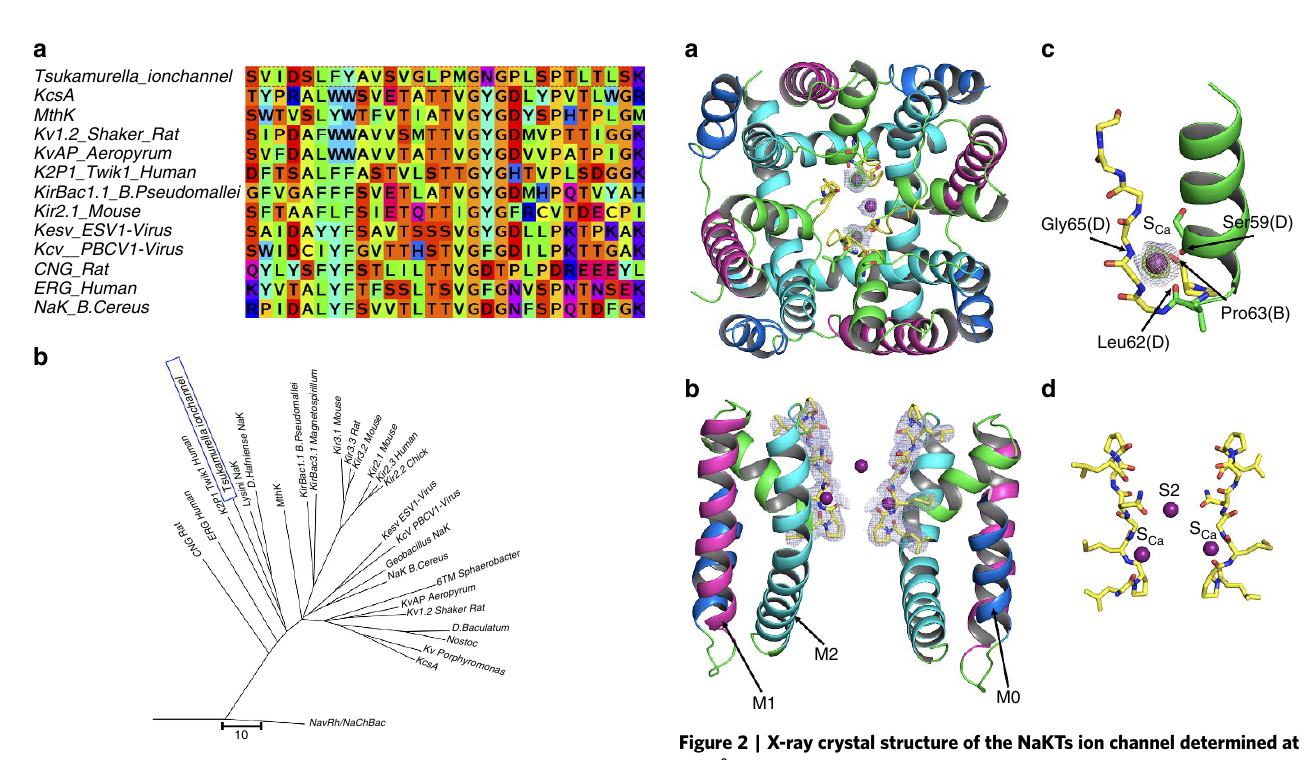
Figure 1 | The NaKTs ion channel in relation with other tetrameric cation channels. ( a ) Multiple sequence alignment of the pore helix and selectivity filter regions for the NaKTs ion channel protein along with K þ , Na þ and non-selective channels. The multiple sequence alignment was done using Clustalw and JalView (the colour coding is based on the Taylor scheme available in JalView). ( b ) Phylogenetic tree (scored from pore helix and filter region). The phylogenetic tree was generated based on the multiple sequence alignment of the pore helix and the selectivity filter region only using the programs JalView and MEGA 5.